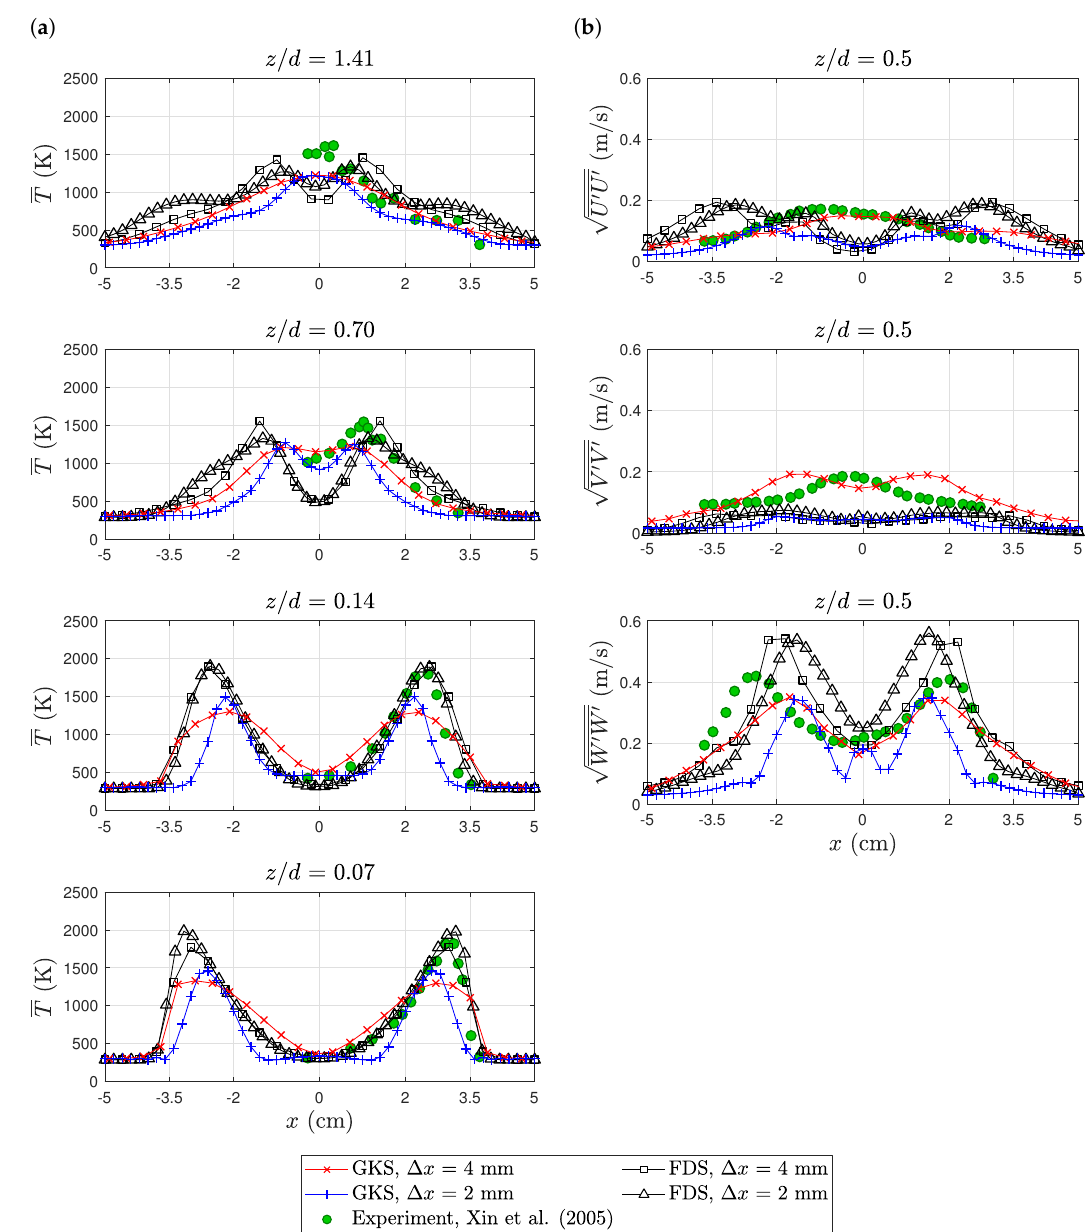
Figure 8. Purdue flame: temperature ( a ) and velocity fluctuation ( b ) profiles. The experimental data are available online at